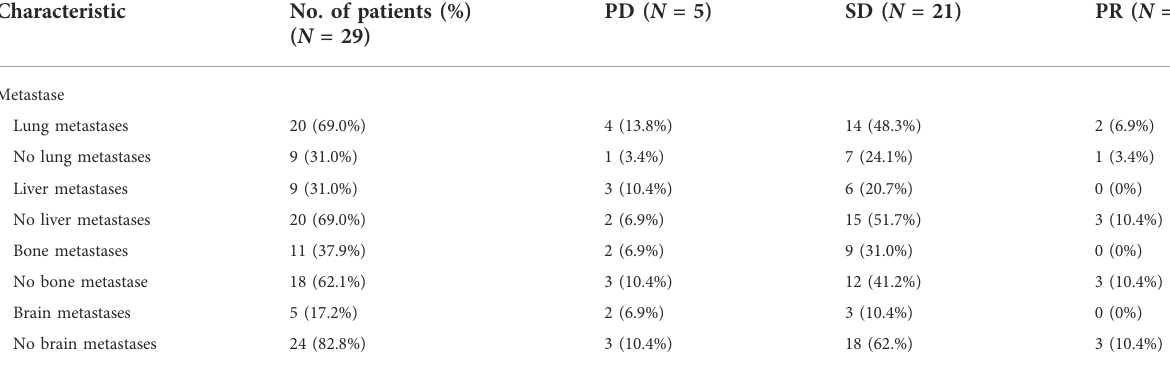
TABLE 3 Demographics of patients with metastasis and metastasis